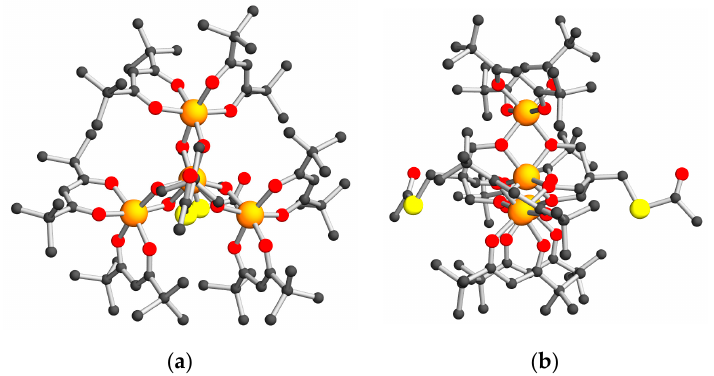
Figure 2. Molecular structure of MOL1 in 2 ·Et 2 O viewed along ( a ) and perpendicular to ( b ) the idealized three-fold axis. Same color code as in Figure 1. Minority components of disordered t Bu groups and hydrogen atoms have been omitted.